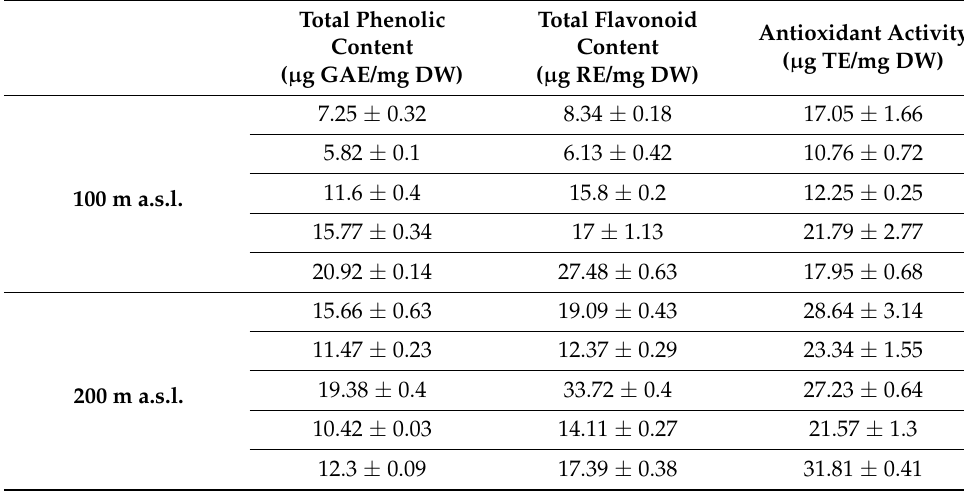
Table 1. Total phenolic content, total flavonoid content and antioxidant activity of samples collected on Stromboli Island and different altitudes. Values are expressed as mean ± standard